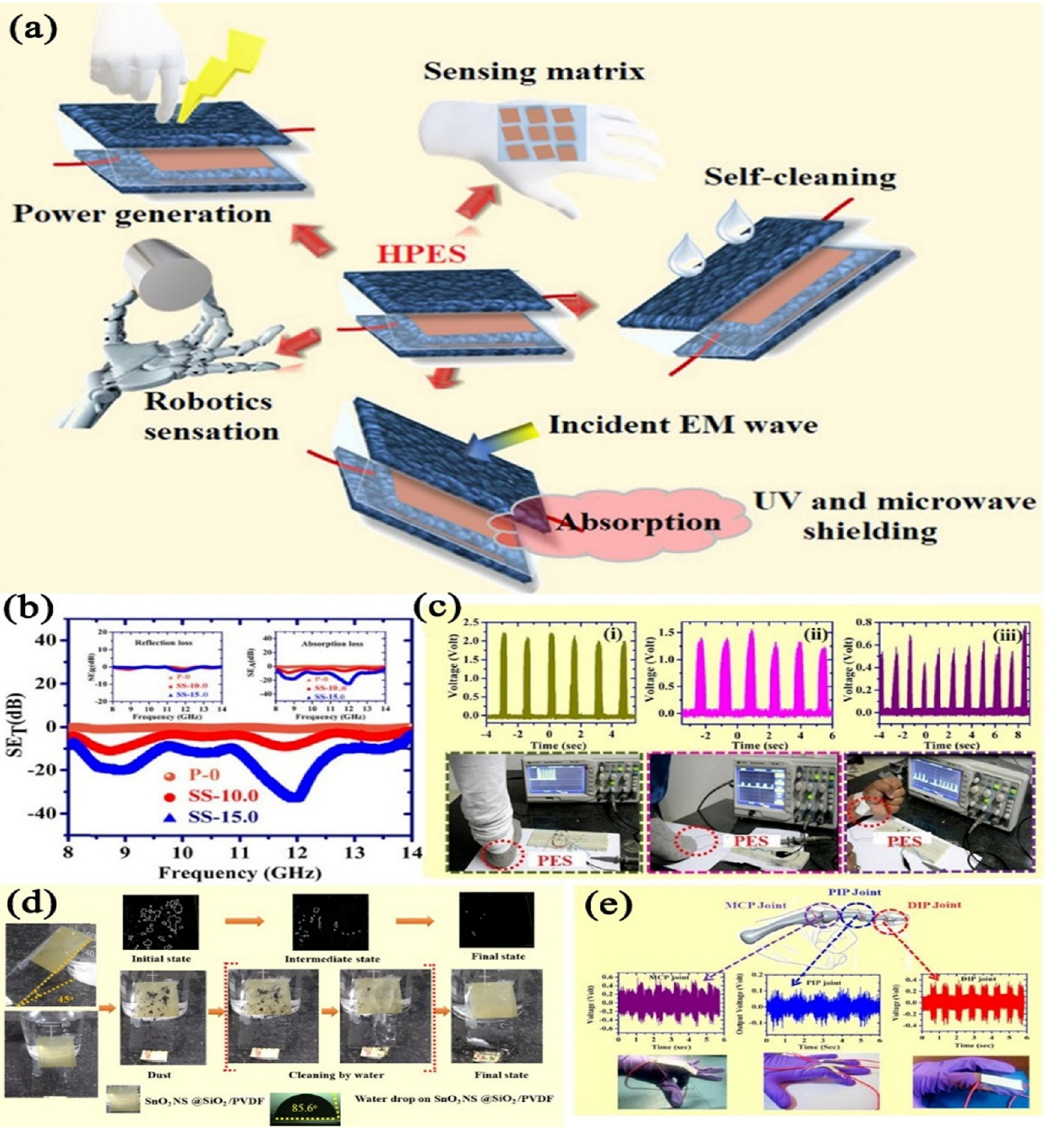
Figure 24: ( a ) Schematic diagram of HPES application, ( b ) total shielding e ff ectiveness of pure PVDF and SS fi lms as a function of frequency, ( c ) PES - generated voltages under ( i ) heel movement, ( ii ) toe movement, and ( iii ) wrist fl exion, ( d ) self - cleaning process of PES membrane, ( e ) monitoring of human directional fi nger joint movements through a health data glove [ 149 ] ; Copyright: 2019 with permission from